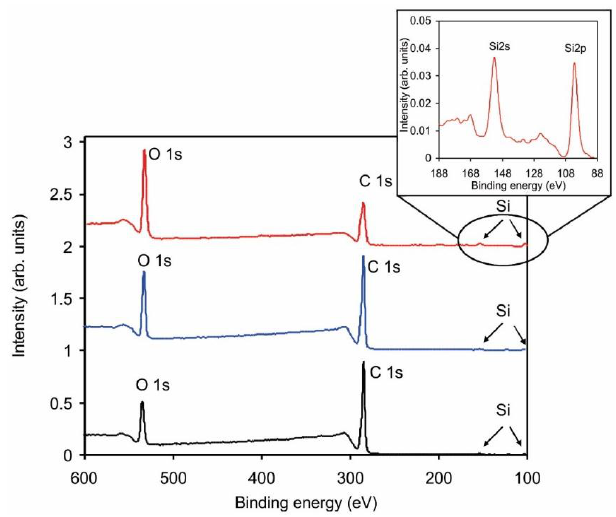
Figure 8. Selected XPS survey spectra of the untreated ( lowest curve ) and treated polymer at a low fluence of 0.4 × 10 22 m –2 ( middle ) and at a high fluence of 82 × 10 22 m –2 ( upper curve ).